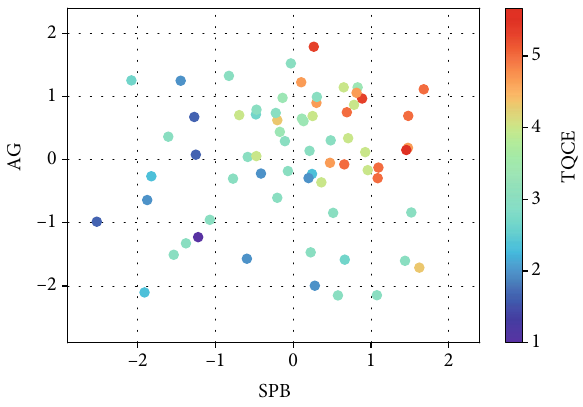
Figure 2: Scatter plot of SPB and AG with colour bar of